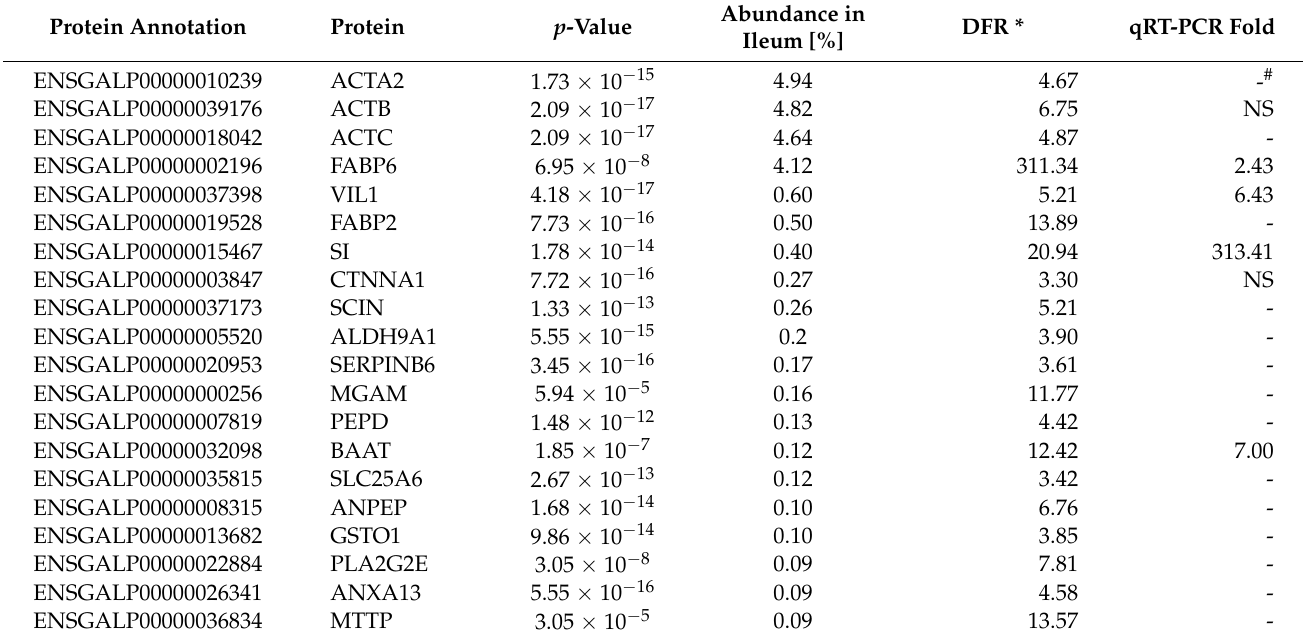
* DFR—differential fold ratio of protein abundance in the ileum compared to caecum. # “-“ = not tested, NS = not